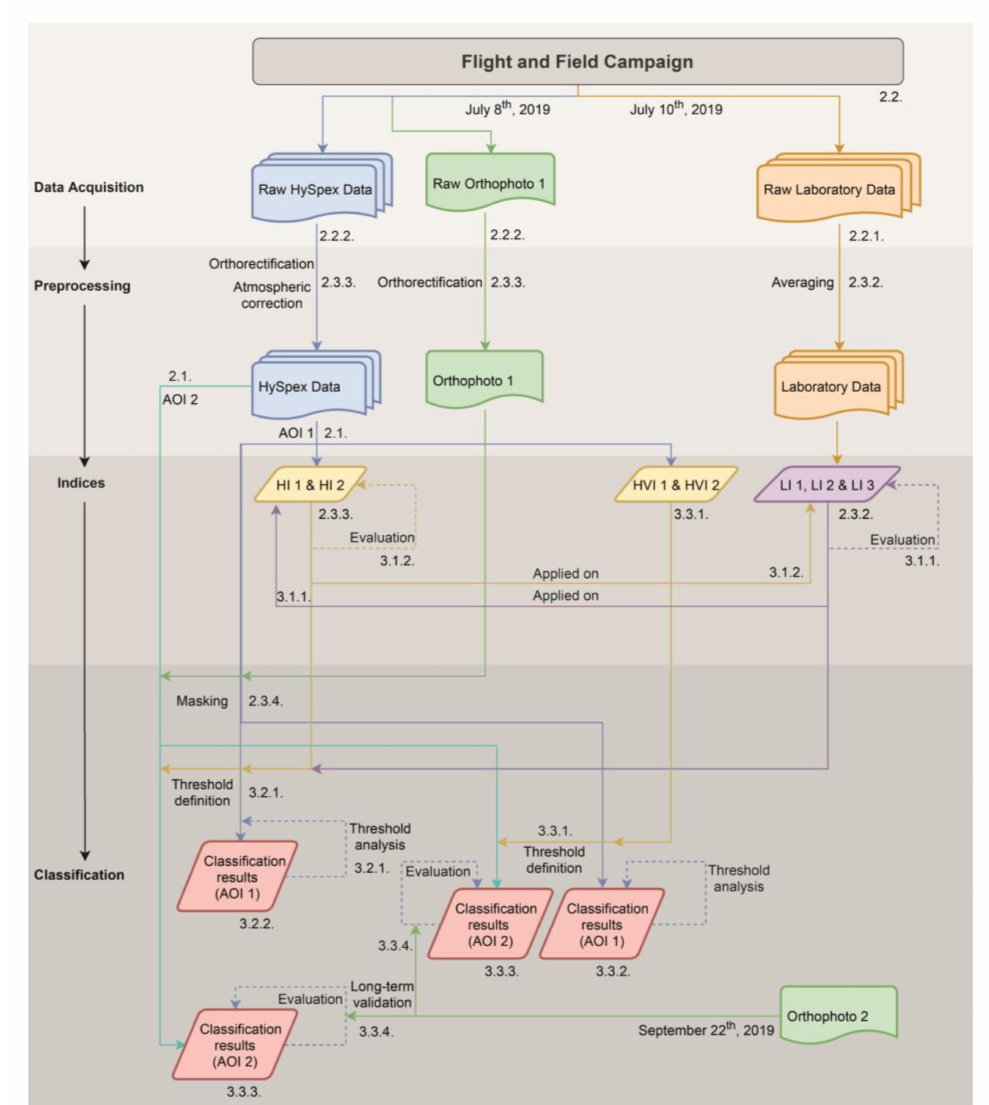
Figure 6. Flowchart of the methodical work steps including section numbers. While Section 2. describes the data acquisition and the preprocessing, Section 3. presents the results of the analysis of indices and the classification. Different colors were used for different data types and results (blue = HySpex data, green = orthophotos, orange = laboratory data, yellow = HySpex and hyper- spectral vegetation indices, purple = laboratory indices, red = classification results). Solid arrows indicate data applied or processed on other data, while dashed arrows illustrate a comparison or validation of the same